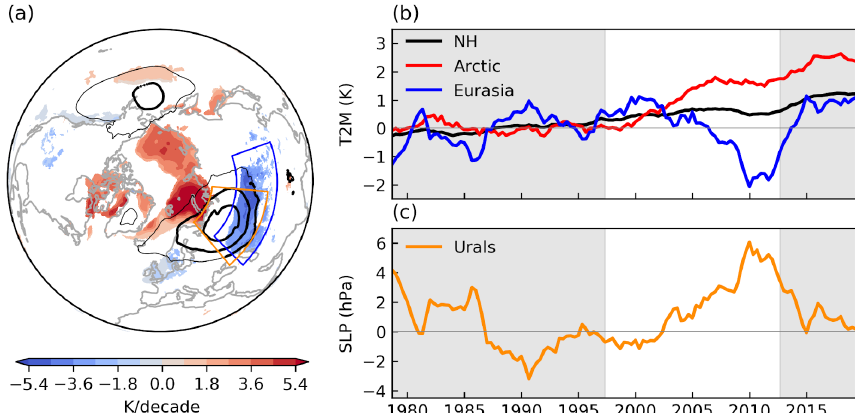
Figure 1. The “warm Arctic–cold Eurasia” pattern and the associated surface circulation. (a) Trends in wintertime 2m air temperature (shad- ing) and sea level pressure (contours with levels: 3, 6, 9hPa/decade) in ERA5 reanalysis for 1998 to 2012 over the Northern Hemisphere. Trends for 2m air temperature are only shown for locations that are significantly different at the 95% level from the mean Northern Hemi- sphere trend for the given period. Trends for sea level pressure are shown in thick (thin) contours for locations that are significantly different (not significantly different) at the 95% level from the mean Northern Hemisphere trend for the given period. The blue (orange) box denotes the Eurasian (Urals) region for calculating the area-averaged indices in panels (b, c) . (b) Indices of area-averaged 2m air temperature over the Northern Hemisphere (20–90 ◦ N, black), Arctic (60–90 ◦ N, red), and Eurasia (40–60 ◦ N, 45–110 ◦ E, blue) from 1979 to 2019. (c) Indices of area-averaged sea level pressure over the Urals (45–70 ◦ N, 40–85 ◦ E) from 1979 to 2019. (b–c) The indices are constructed from monthly values from December to February. The monthly climatology has been removed relative to a 1979–1998 period and a 5-year running mean applied. The unshaded region corresponds to the period from 1998 to